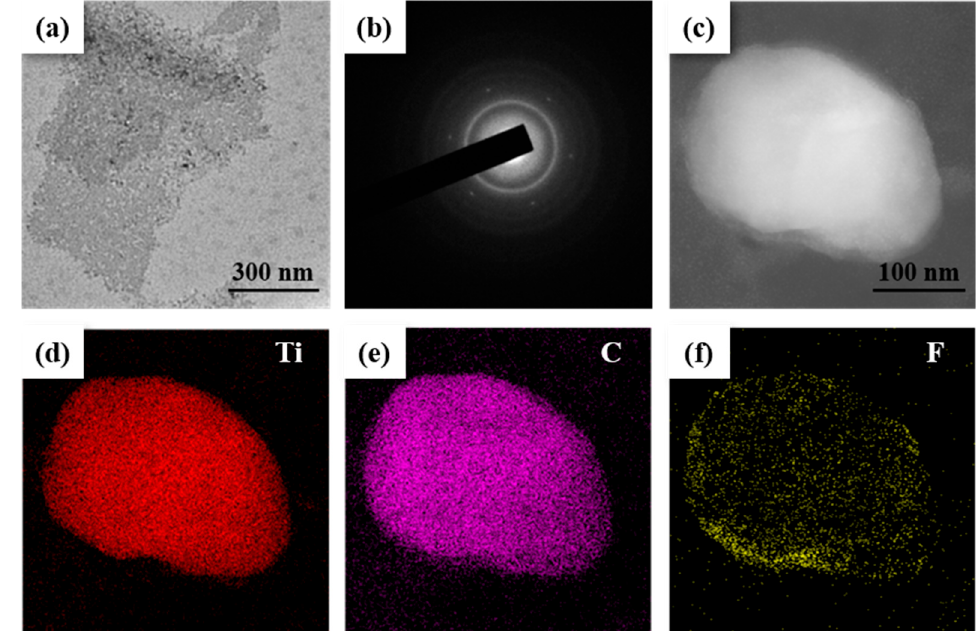
Figure 1. Characterization of MXene Ti 3 C 2 T x : ( a ) TEM image of the Ti 3 C 2 T x nanoflakes; ( b ) SAED patterns of the Ti 3 C 2 T x nanoflakes; ( c ) STEM of a Ti 3 C 2 T x nanoflake; ( d – f ) elemental maps of the nanoflake in Figure ( c ), which were obtained from the EDS results.